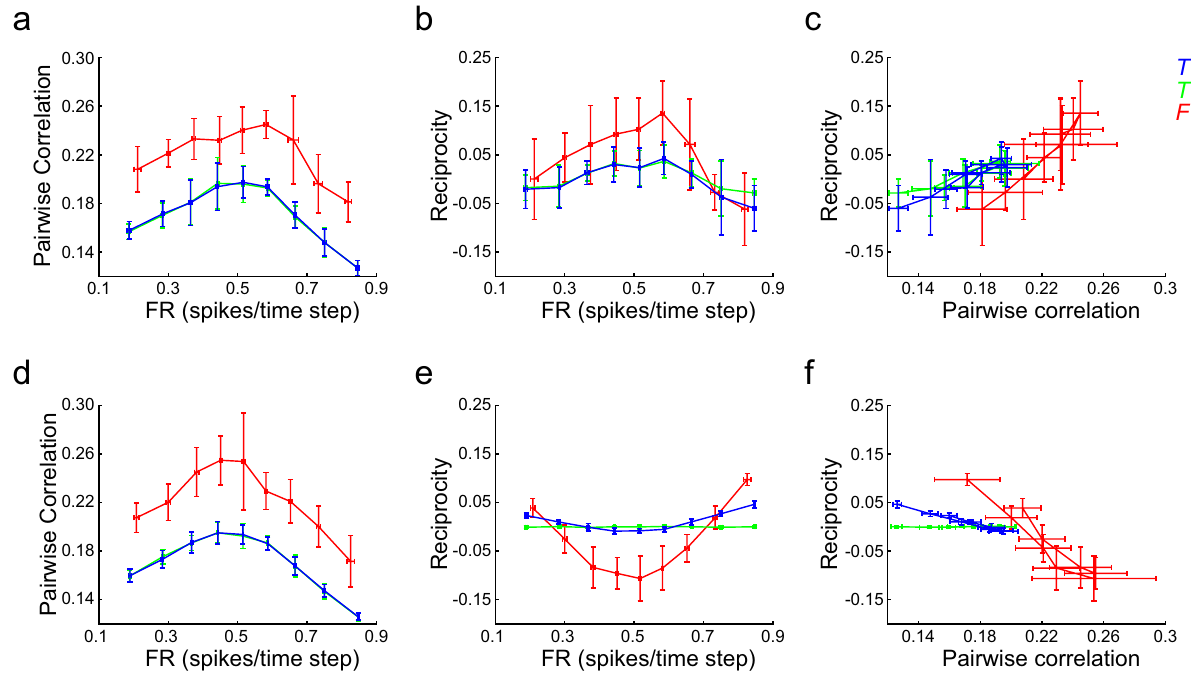
Figure 6. Correlation and reciprocity differentiate networks with sequence memory from random transition networks. ( a–c ) Networks constructed to solve the s-task with τ = 7 and f r = 1 ( T + F networks), their isofunction network ( T network), and networks with the same number of neurons and network states that follow a random transition graph ( F networks). ( a ) Correlation increases as FR approaches 0.5 spikes/time step. F networks show a positive offset in comparison with T + F and T networks. ( b ) The dependency between reciprocity and FR is similar to the dependency between CC and FR. Higher reciprocity values are found in F networks. ( c ) Reciprocity grows linearly with correlation, as expected from panels ( a ) and ( b ). ( d – f ) idem a–c , but with f r = 4 . ( d ) The CC/FR relationship is similar to the one observed with a lower neuron number (panel (a)). ( e ) The reciprocity/FR relationship inverted as the neuron number was increased. Reciprocity is minimized as FR approaches 0.5 spikes/time steps. F networks show pronounced negative reciprocity. ( f ) Reciprocity decreases linearly with correlation, as expected from panels ( d ) and ( e ). Mean ± SD are shown; n = 10 networks were constructed for each target FR and network type. All random graphs were constructed with f bc = 0.25